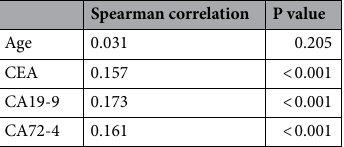
Table 3. Correlation between NLR and clinicopathological characteristics.